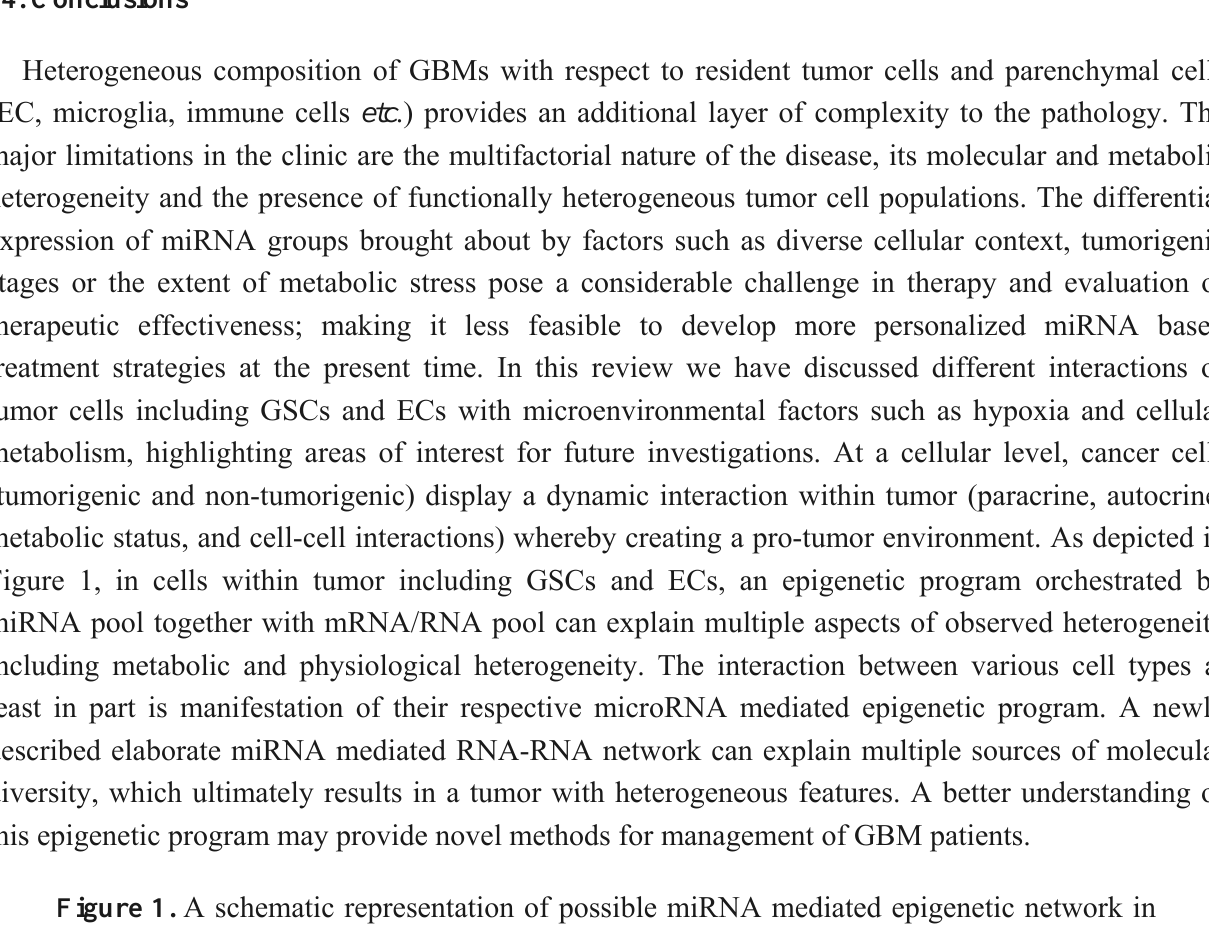
Figure 1. A schematic representation of possible miRNA mediated epigenetic network in tumorigenic cancer stem cells (GSCs; shown in black font color) and tumor associated normal cells (endothelial cells; shown in blue font color) within the tumor microenvironment. Double-headed black arrow represents cell-to-cell communication in tumor microenvironment and influence of extra-cellular factors on cellular